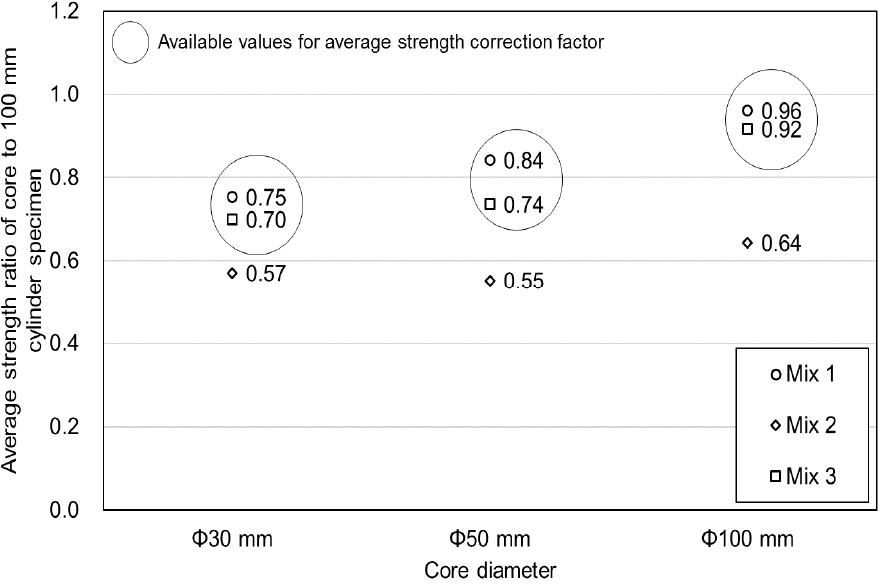
Figure 10. Average strength ratio for core specimens according to core diameter.